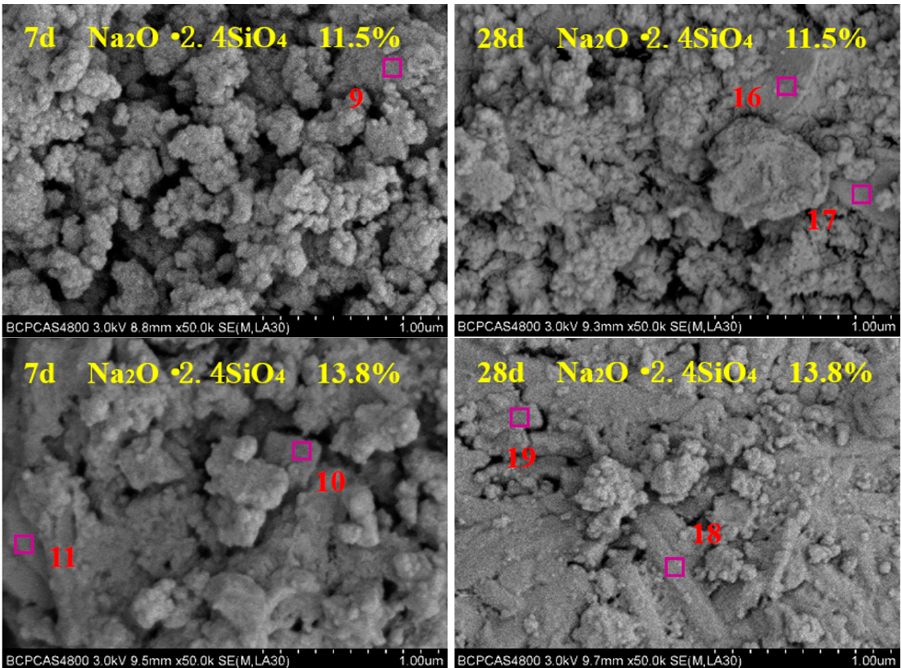
Figure 5. SEM images of composite alkali-activated cementitious materials after curing for 7 and 28 days. Table 4. EDS analysis of composite alkali-activated cementitious materials and the corresponding phases. Atomic Molar Ratio Region Micromorphology